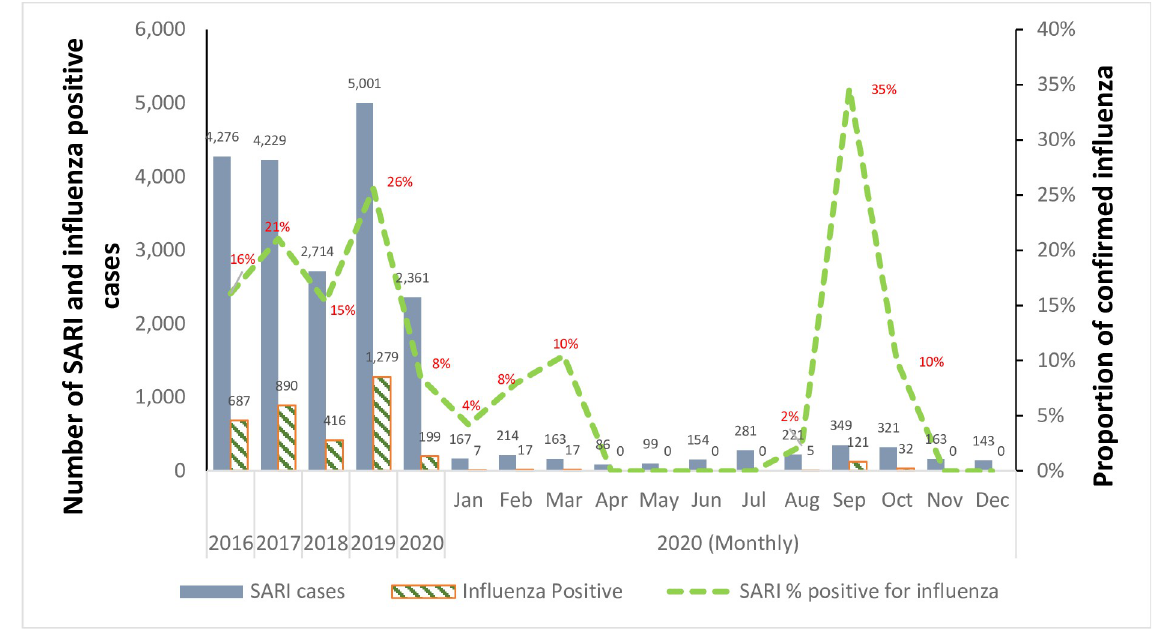
Fig 1. SARI cases and influenza infection detected through hospital-based influenza surveillance in Bangladesh, 2016–2020.